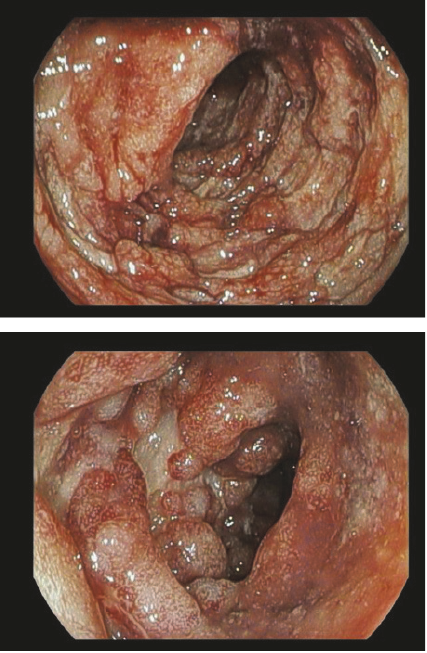
Figure 1: Endoscopic evaluation on presentation. Severe colitis seen throughout the colon.